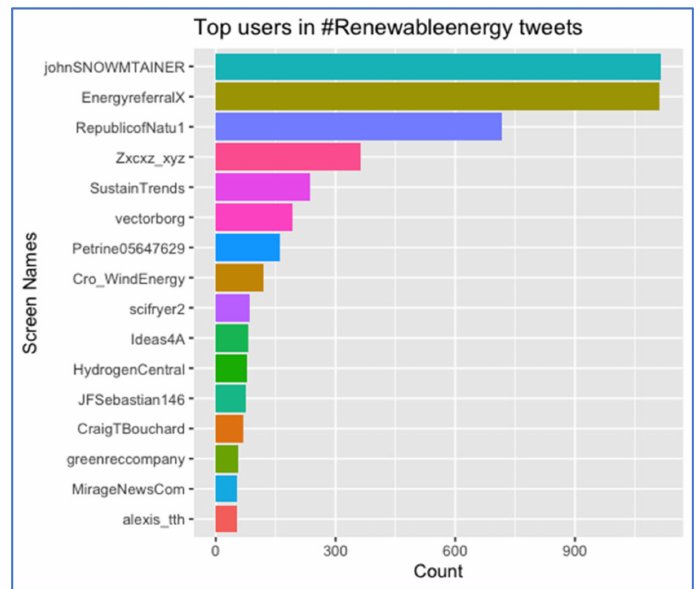
Figure 7. Top users in #renewableenergy